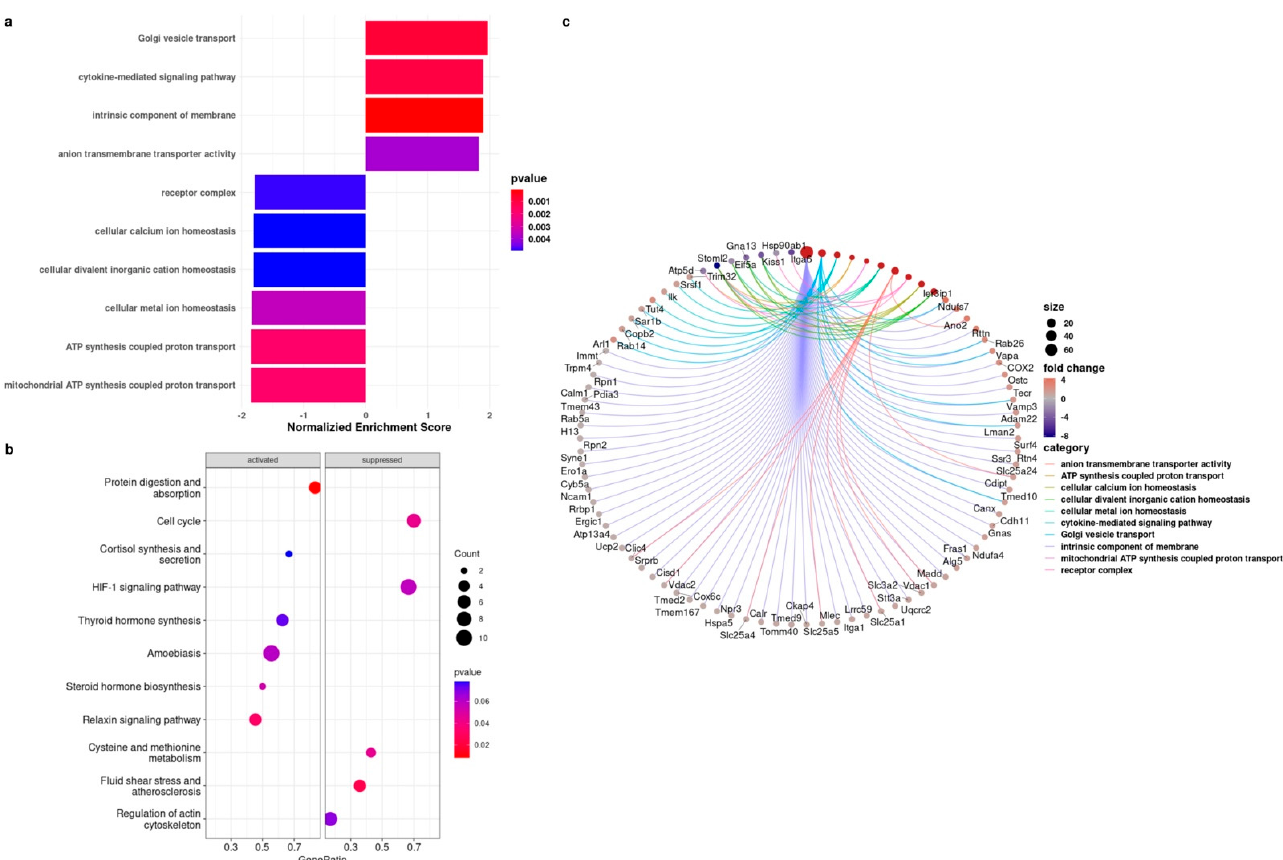
Figure 4. Proteomics analysis of the early and late passages of BMR cells. ( a ) The bar graph illustrates the pathway enrichment visualization process overrepresented in the related pathways in late passage cells compared to early passage cells with a normalized enrichment score. ( b ) A dot plot representation of the KEGG pathway enrichment analysis shows the activated and suppressed biological processes in late passage cells compared to early passage cells. The dot size is based on the gene count enriched in the pathway, and the color of the dot shows the pathway enrichment significance. Gene set enrichment analyses (GSEAs) were performed with multiple test corrections (Benjamini–Hochberg). ( c ) The Cnet plot of the BMR proteomics analysis is shown. Each line shows the pathway and gene association. The fold changes of proteins are colored between red and blue. The gene ratios of the pathways are presented as the size of a circle. Pathways were selected as statistically significant at the p < 0.05 cutoff ( n = 4).